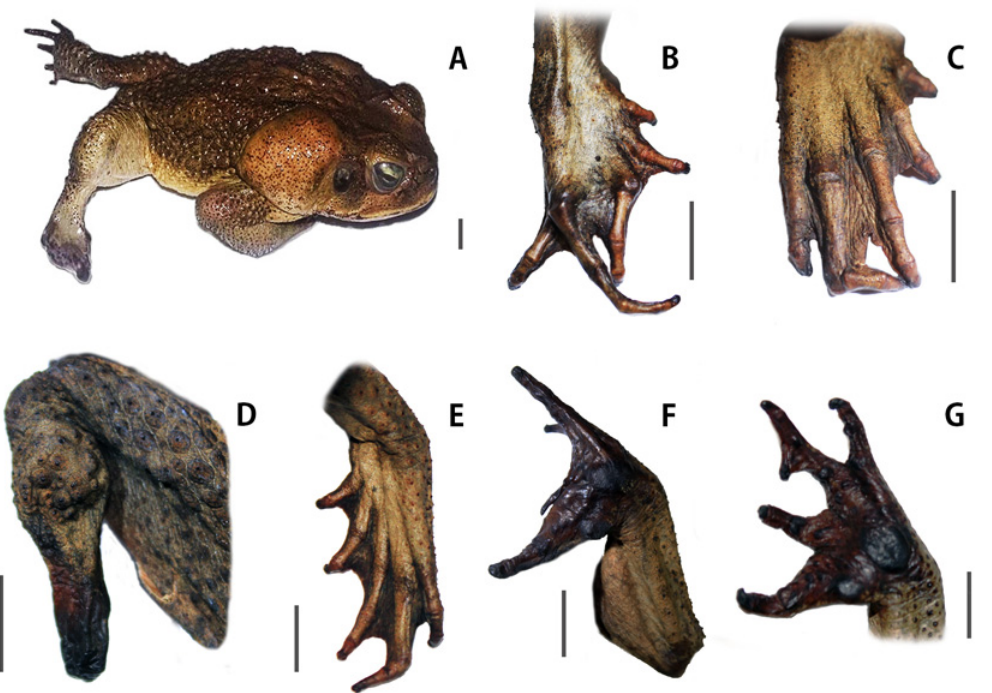
Fig 3. Adult toads ( Rhinella marina ) collected in Bailique Island showing deformities. (A and D) Individuals with Hemimelia (partially missing limb); (B, C and E) Digit bent at joint; (F) Forked digits; Polydactyly (G) (Photographs: Adam R. Bessa-Silva and Davidson Sodré). Scales = 1 cm.